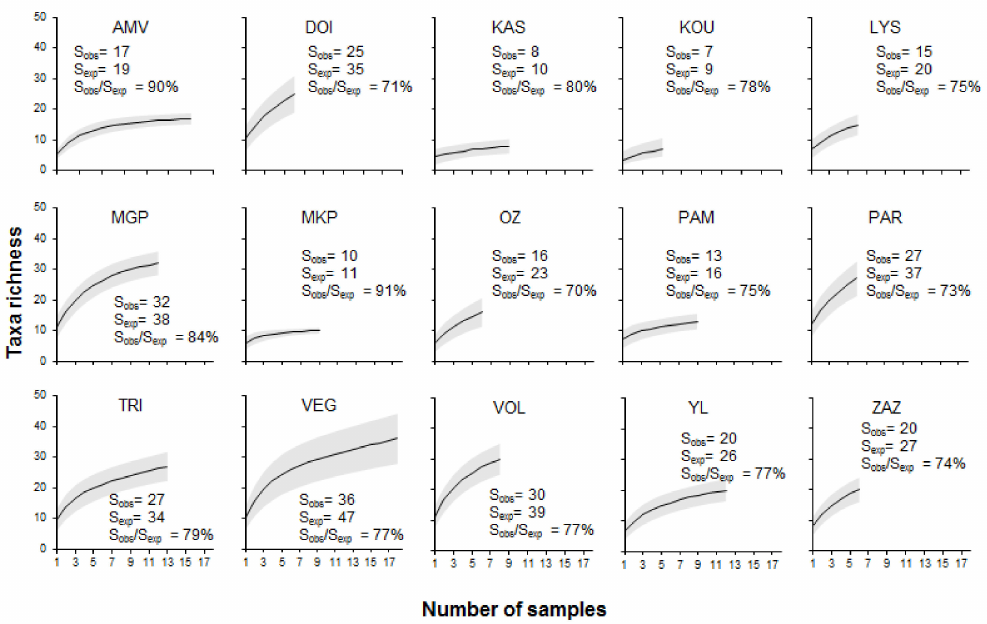
Figure 6. Taxa rarefaction curves at the sublittoral/profundal zone. Observed (Sobs) and estimated (Sexp) taxa richness based on the first-order Jackknife estimator. The gray section represents the ± 95% confidence interval.